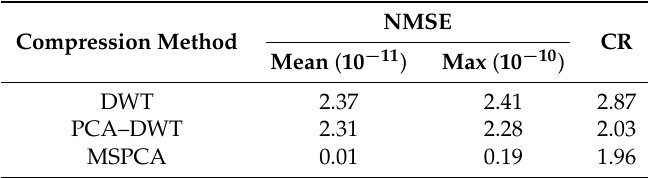
Table 5. Comparison of compression result (frequency). Note: DWT, discrete wavelet transform; PCA, principal component analysis; MSPCA, multiscale principal component